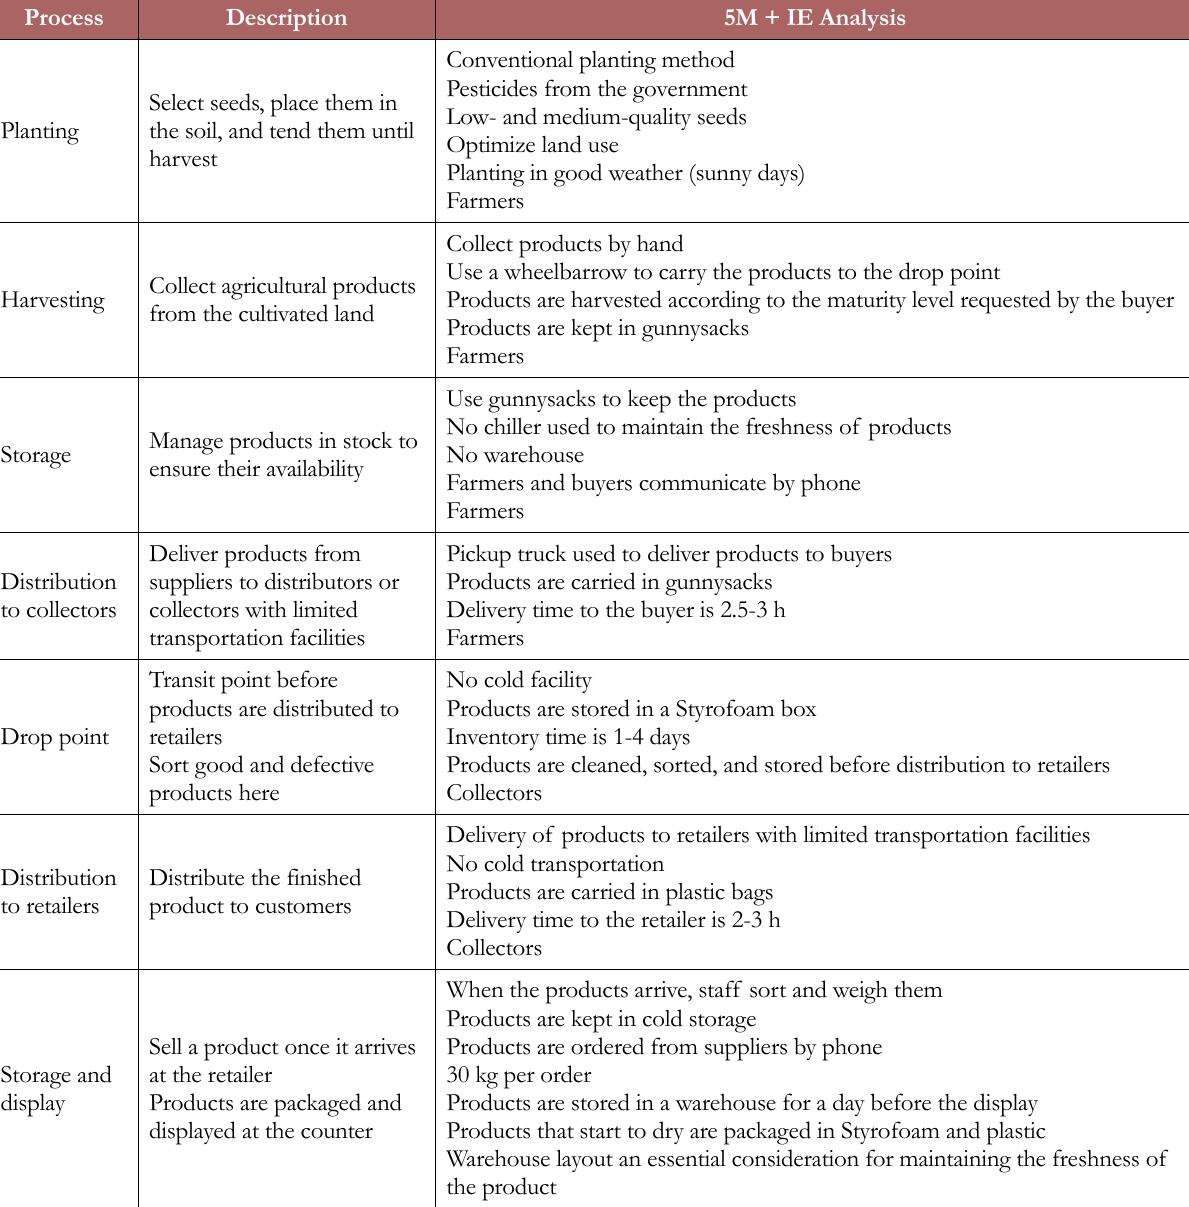
Table 1. Map of the supply chain characteristics